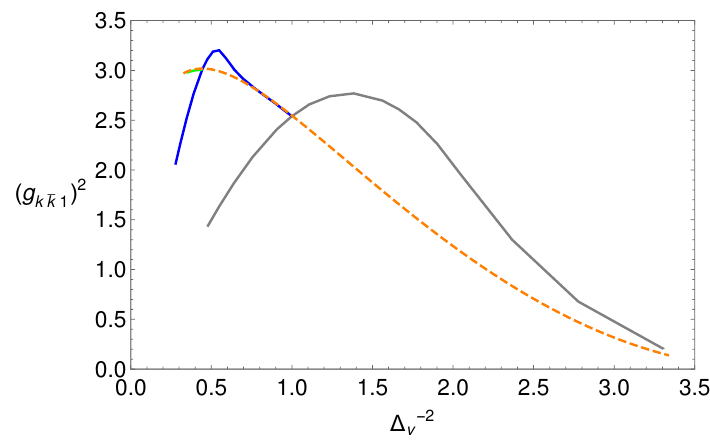
Figure 22 . Bounds in terms on the AdS coupling g 2 grey are the bounds assuming only the bound state of dimension 1, in blue the bounds when we add the bound state of dimension 2 and in green when we further include the bound state of dimension 3. The orange dashed curve is the sine-Gordon correlator for zero AdS radius ( λ = 0 , ∆ 1 = 1 ), which saturates the bound in parts of the two and three bound state